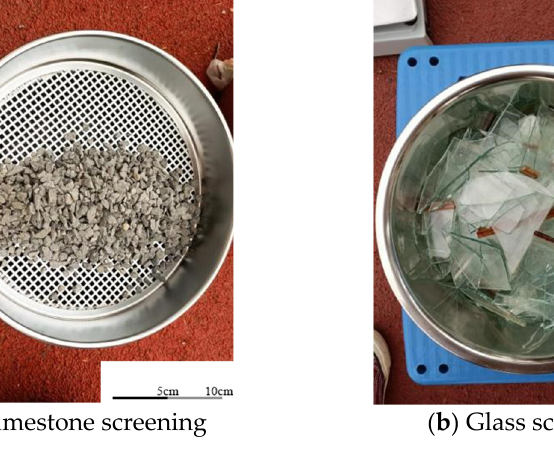
Figure 5. Raw material preparation. Table 3. Local standards of mechanical